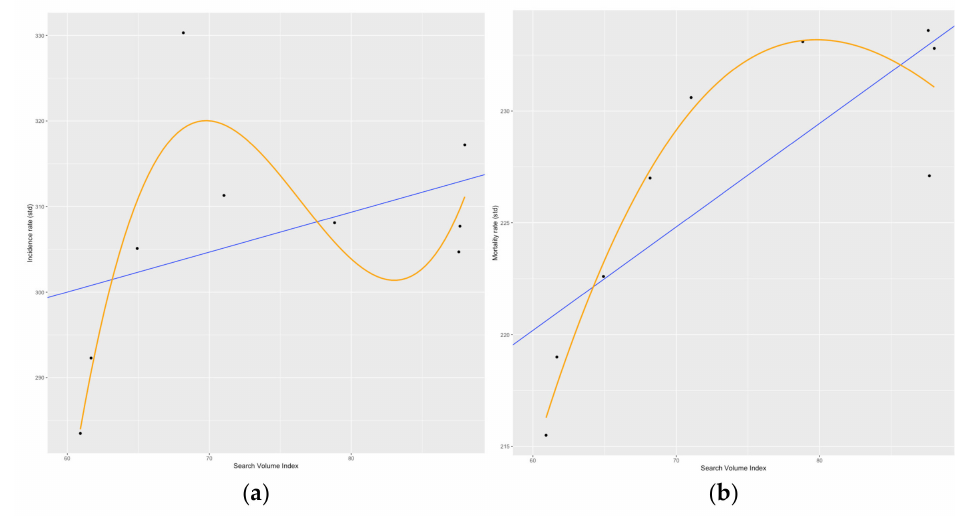
Figure 6. The relationship (linear—blue line, polynomial—orange line) between related web queries and the age-standardized cancer incidence rate in Romania (panel a ). The relationship (linear— blue line, polynomial—orange line) between related web queries and the age-standardized cancer mortality rate in Romania (panel b ). Source of data: Romanian Ministry of Health [32]. All estimations were performed in R software; plots were created in R software (i.e.,“ggplot” function).